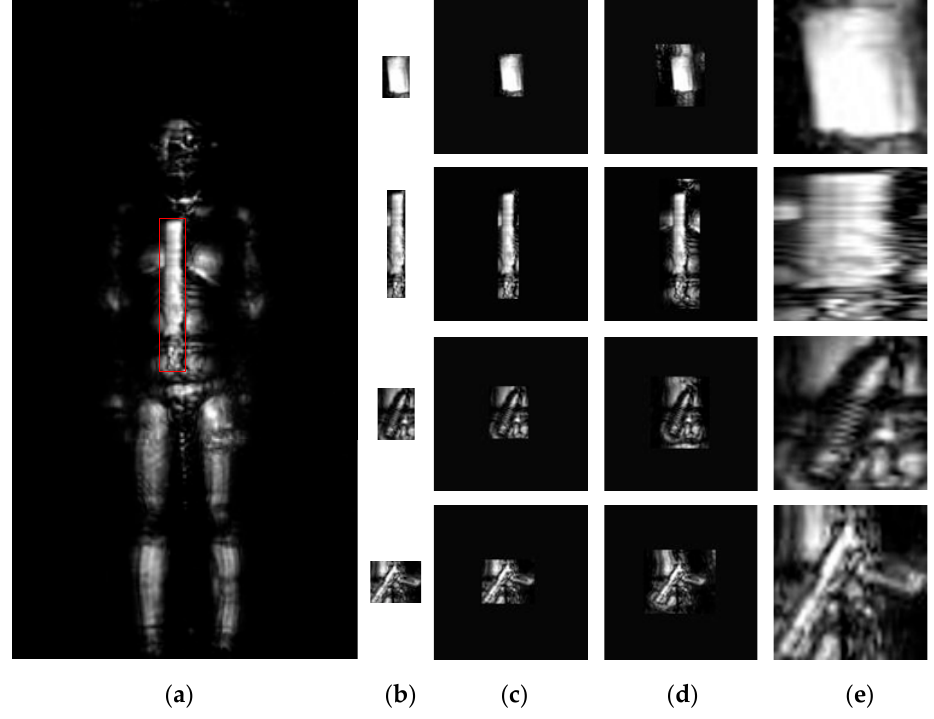
Figure 3. Different transformations of terahertz images. ( a ) An example of the original annotated terahertz image; ( b ) The original cutting images of interesting object; ( c ) Filling with the image mean; ( d ) Cutting with context and filling with image mean; ( e ) Wrapping.